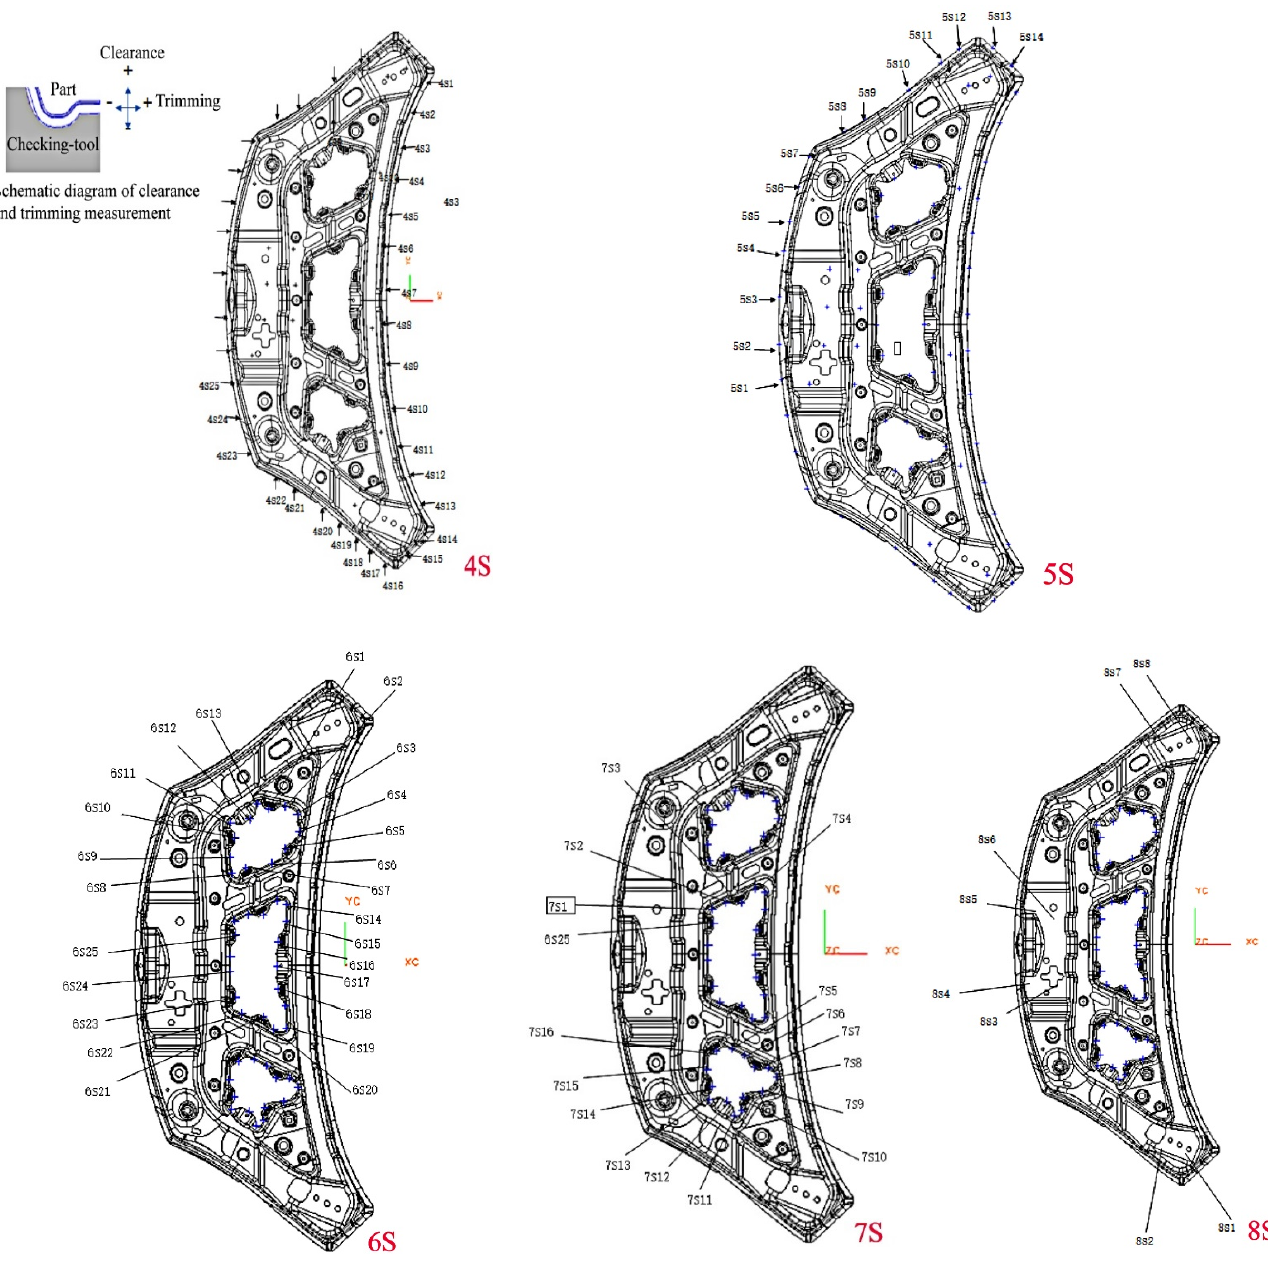
Figure 6. The spring back measurement positions of the profile. The 4S–8S arears are the measurement positions of spring back. Each area measures different points.